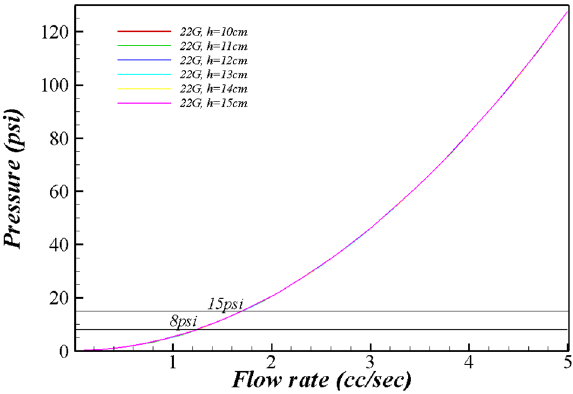
Figure 4. Range of flow rate and pressure for 22